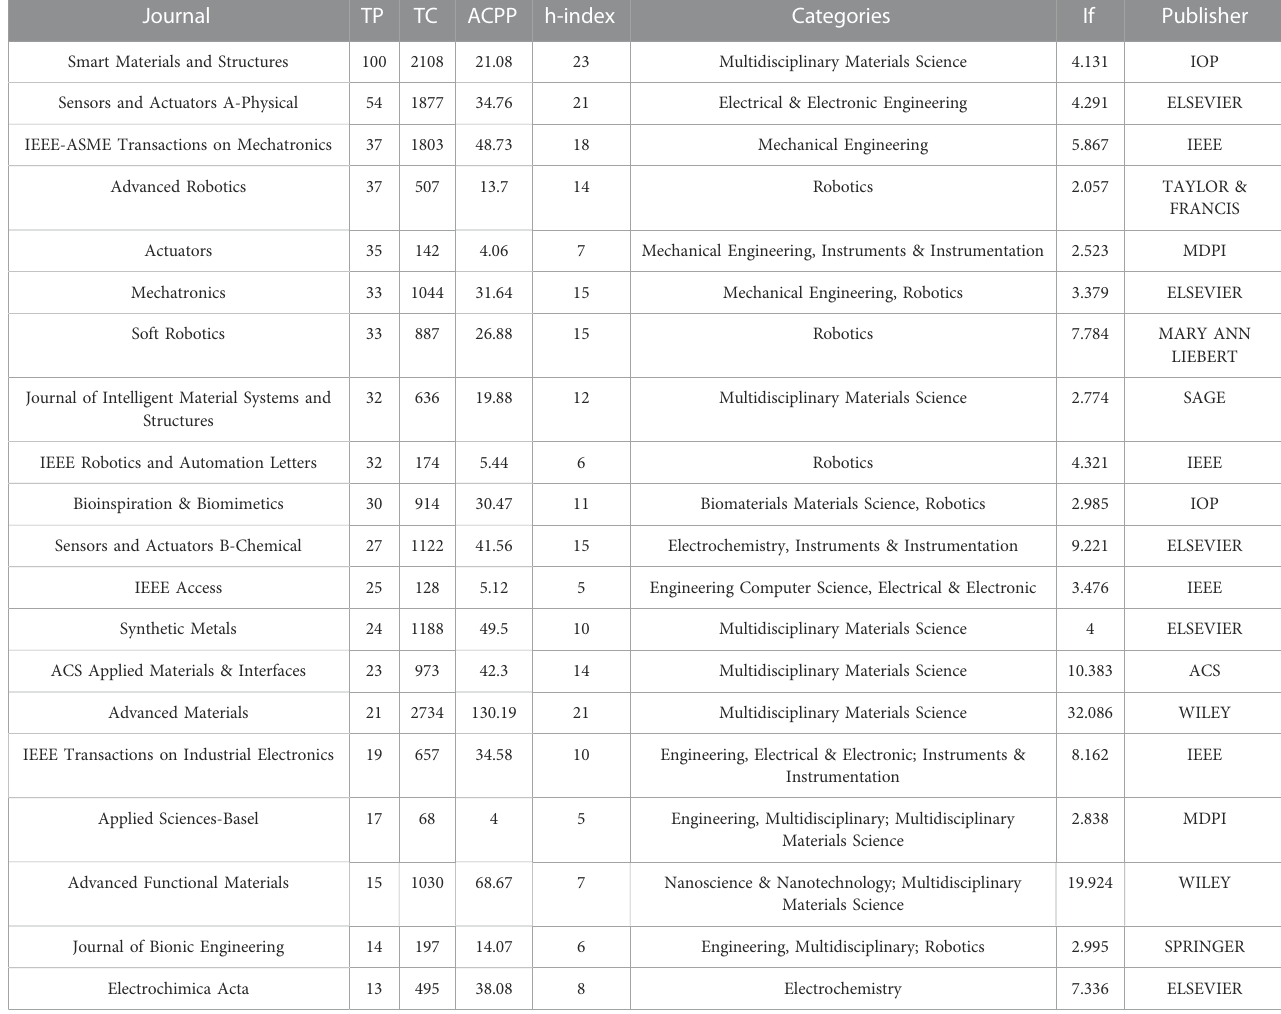
TABLE 3 Contribution of the top 20 most productive journals in arti fi cial muscle